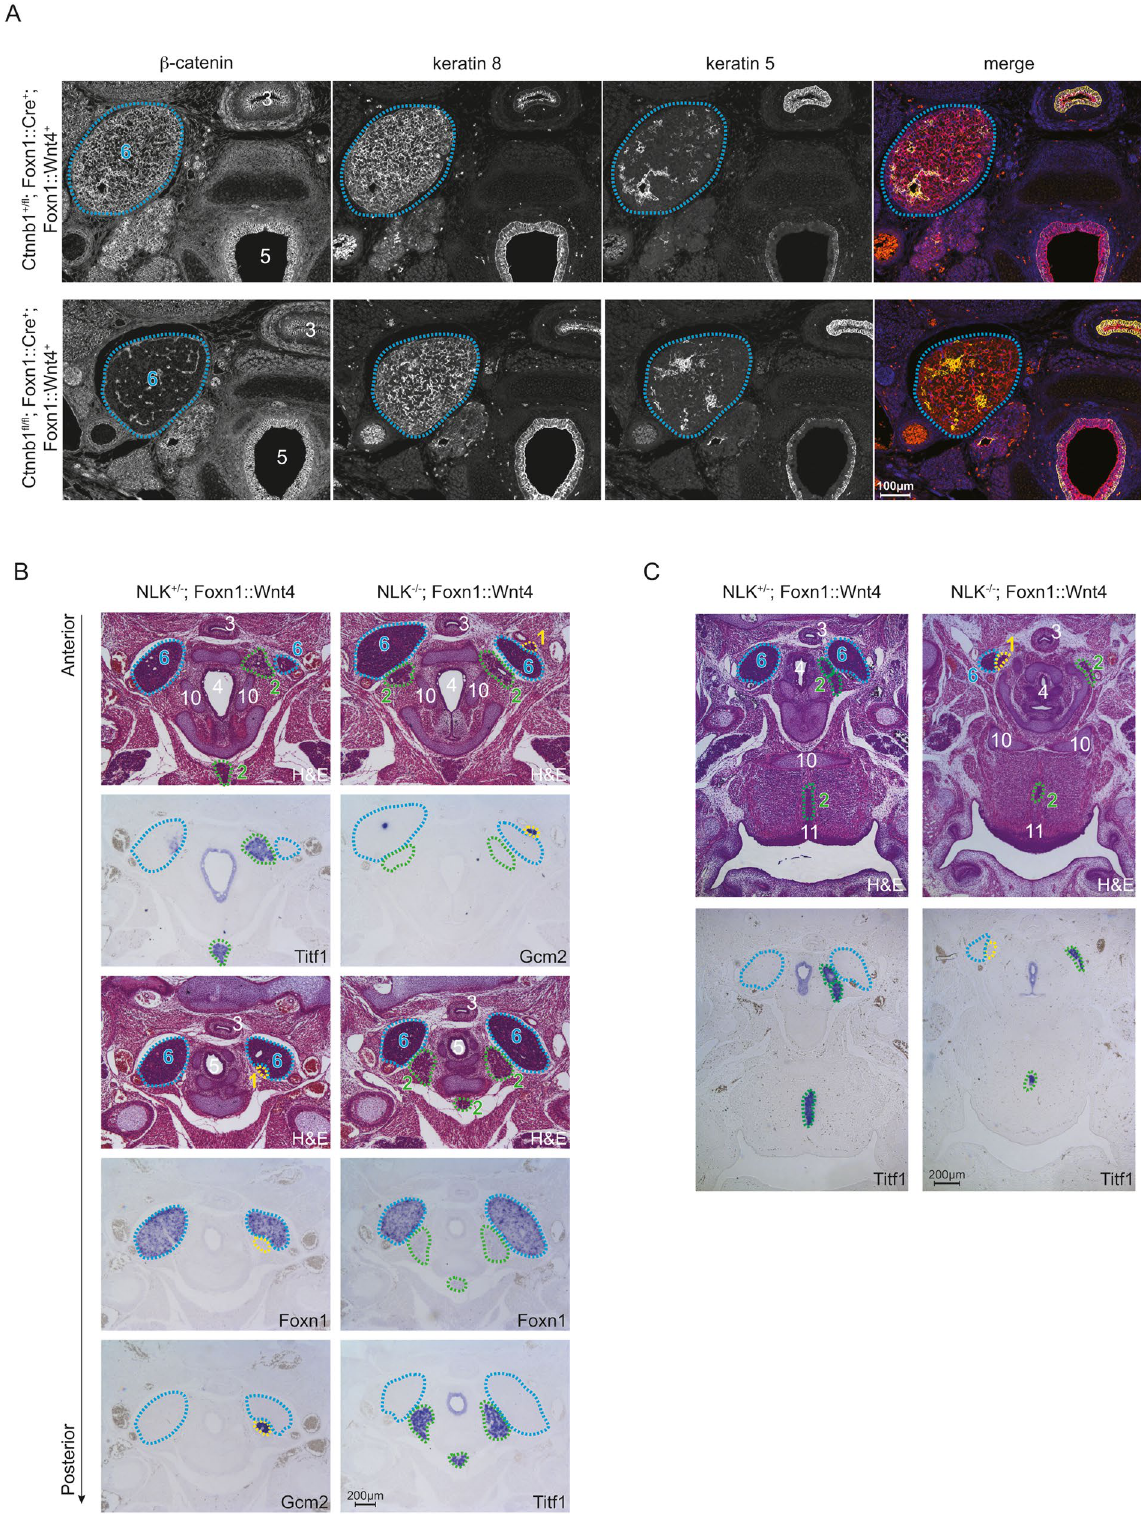
Figure 6. Deficiency in β -catenin or Nlk fails to correct defective organ migration induced by Wnt4- overexpression. ( A ) Immunohistochemistry analysis of E15.5 β -catenin-sufficient (top row) and Ctnnb1- deficient (bottom row) Foxn1::Wnt4 -transgenic embryos. ( B ) Development of thyroid, thymus and parathyroid in E15.5 Nlk -sufficient (left panels) and Nlk- deficient (right panels) Foxn1::Wnt4 -transgenic embryos analyzed as in Fig. 5A. ( C ) Ectopic thyroid tissue in the septum of the tongue identified by H&E staining and RNA in situ hybridization with a Titf1 probe. Ectopic thyroid tissue located ventral to the trachea can also be observed in ( B ), second to top panel in the left column, bottom panel in the right